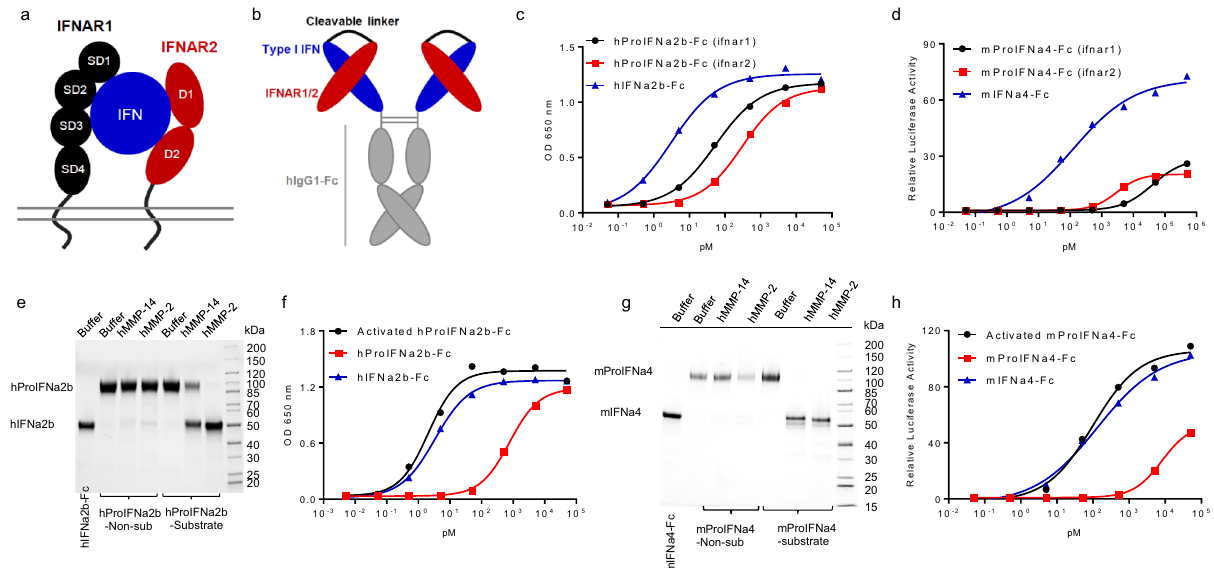
Fig. 1 Blockage of IFN-I activity by IFNAR1/2. a Schematic depicting IFN-I binds to IFNAR1 and IFNAR2. b Design of IFN-I prodrug which IFNAR1/2 extracellular domain fused to IFN-Fc via a cleavable linker. c IFN activity of human IFNAR1/2 masked IFNa2b-Fc was assessed using a human IFN reporter cell line ( n = 2). d IFN activity of mouse IFNAR1/2 masked IFNa4-Fc was assessed using mouse IFN reporter cell line ( n = 2). e Reducing SDS-PAGE analysis of hProIFNa2b-Fc as well as MMP-14- or MMP-2-cleaved hProIFNa2b-Fc. The experiment was repeated two times independently with similar results. f IFN activity of MMP-activated hProIFNa2b-Fc, hIFNa2b-Fc, and hProIFNa2b-Fc was assessed via human IFN reporter cell line ( n = 2). g Reducing SDS-PAGE analysis of mProIFNa4-Fc as well as MMP-14- or MMP-2-cleaved mProIFNa4-Fc. The experiment was repeated two times independently with similar results. h IFN activity of MMP-activated mProIFNa4-Fc, hIFNa2b-Fc, and mProIFNa4-Fc was assessed via mouse IFN reporter cell line ( n = 2). Human IFN activity was assessed by 293T-Dual ™ hSTING-R232 cells via secreted embryonic alkaline phosphatase activity. Mouse IFN activity was assessed by RAW-Lucia ISG cells via secreted coelenterazine-utilizing luciferase activity. Source data are provided as a Source Data fi (IFN- γ ), interleukin-6 (IL-6), and monocyte chemoattractant